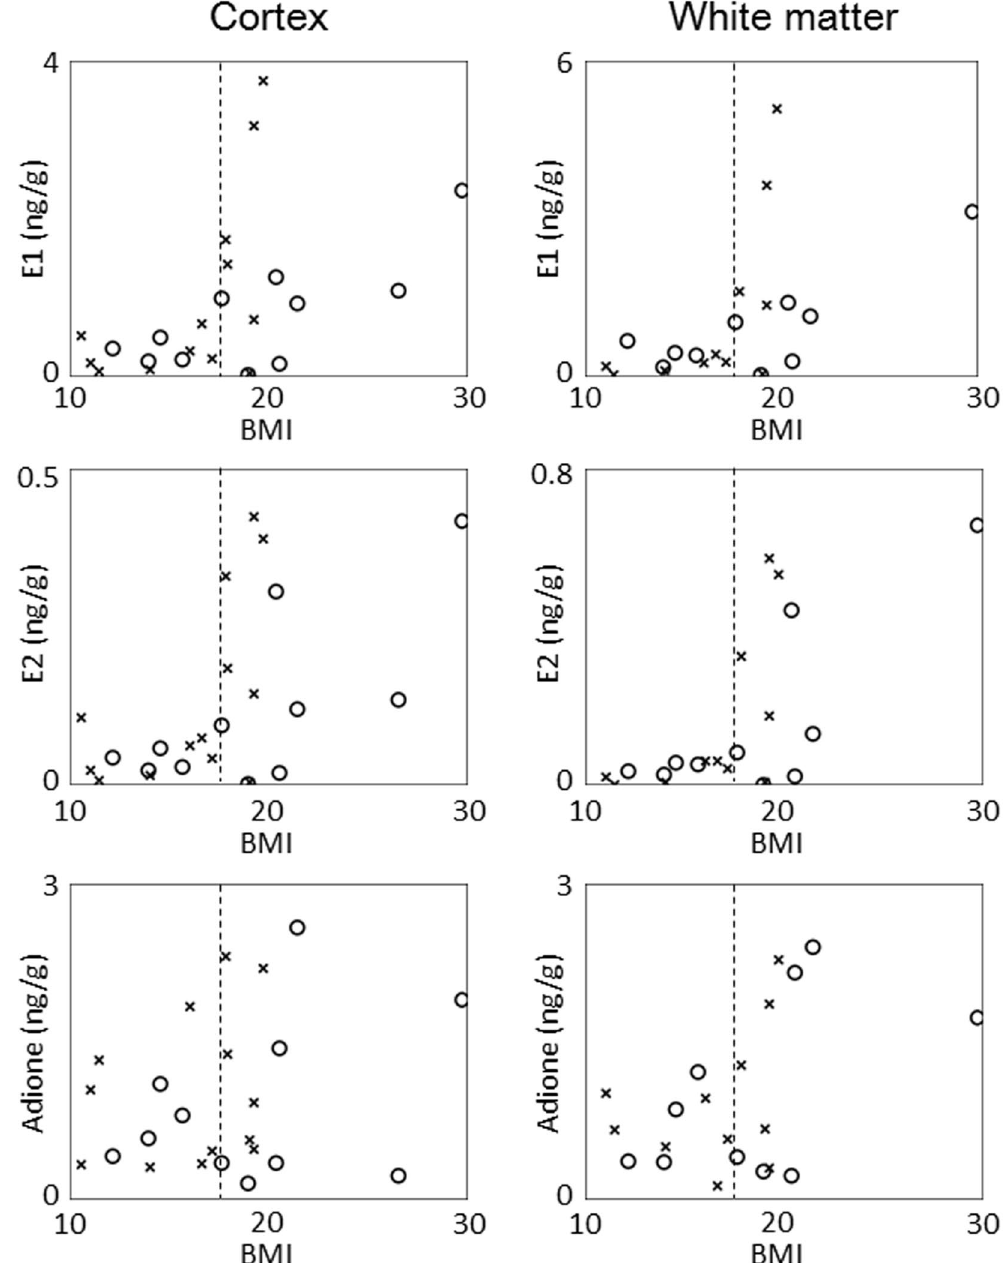
Figure 2. Association between body mass index (BMI) and concentrations of estrone (E1, upper), estradiol (E2, middle), and androstenedione (Adione, lower) in the cortex (left) and white matter (right) of the frontal lobe. ○ and × represent controls and AD patients, respectively. Dotted line, BMI =